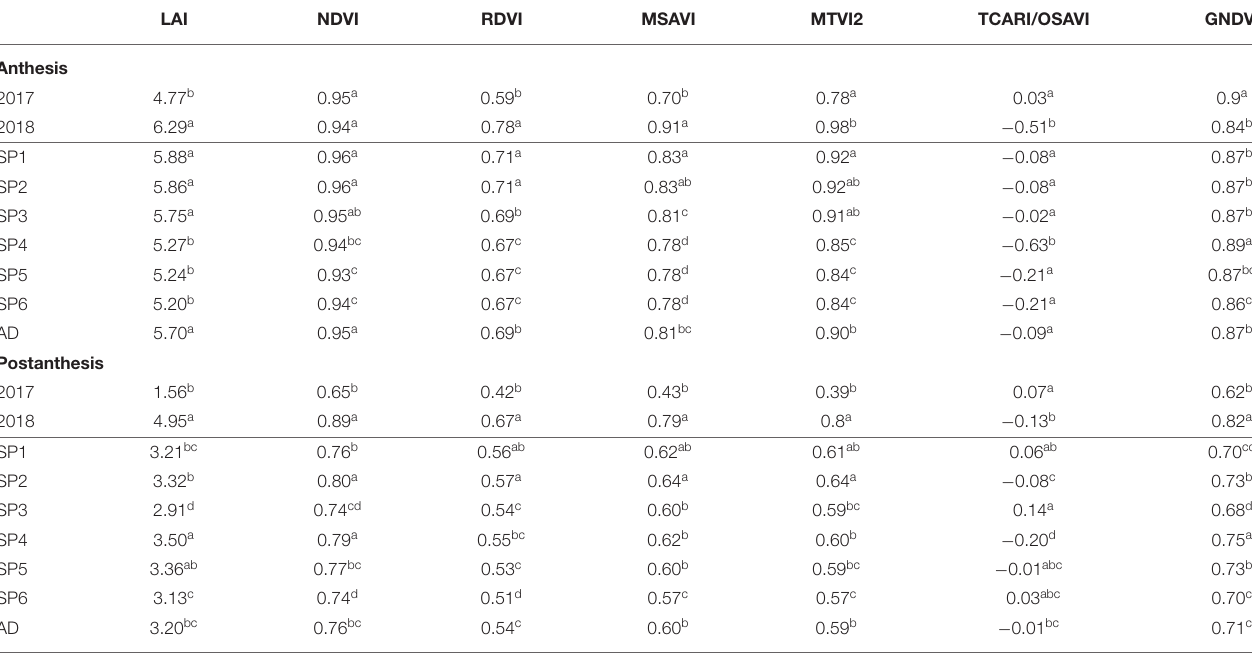
TABLE 6 | Mean values of the LAI estimated by MTVI2 and all the VIs at anthesis (A) and postanthesis (PA) stages in 2017 and 2018 as well as for each genetic subpopulation and the group of admixed genotypes from a set of 170 landraces and 184 modern bread wheat cultivars. LAI NDVI RDVI MSAVI MTVI2 TCARI/OSAVI GNDVI